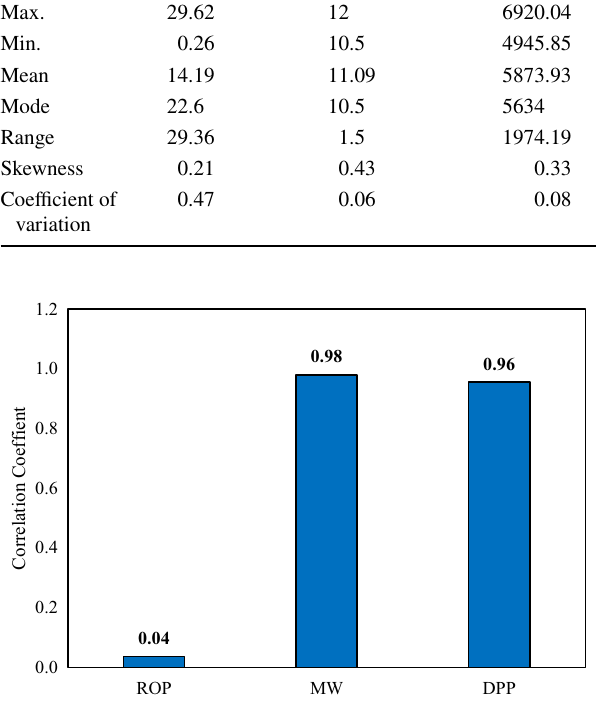
Fig. 5 The correlation coefficient between individual surface param- eters and the measured ECD in the available